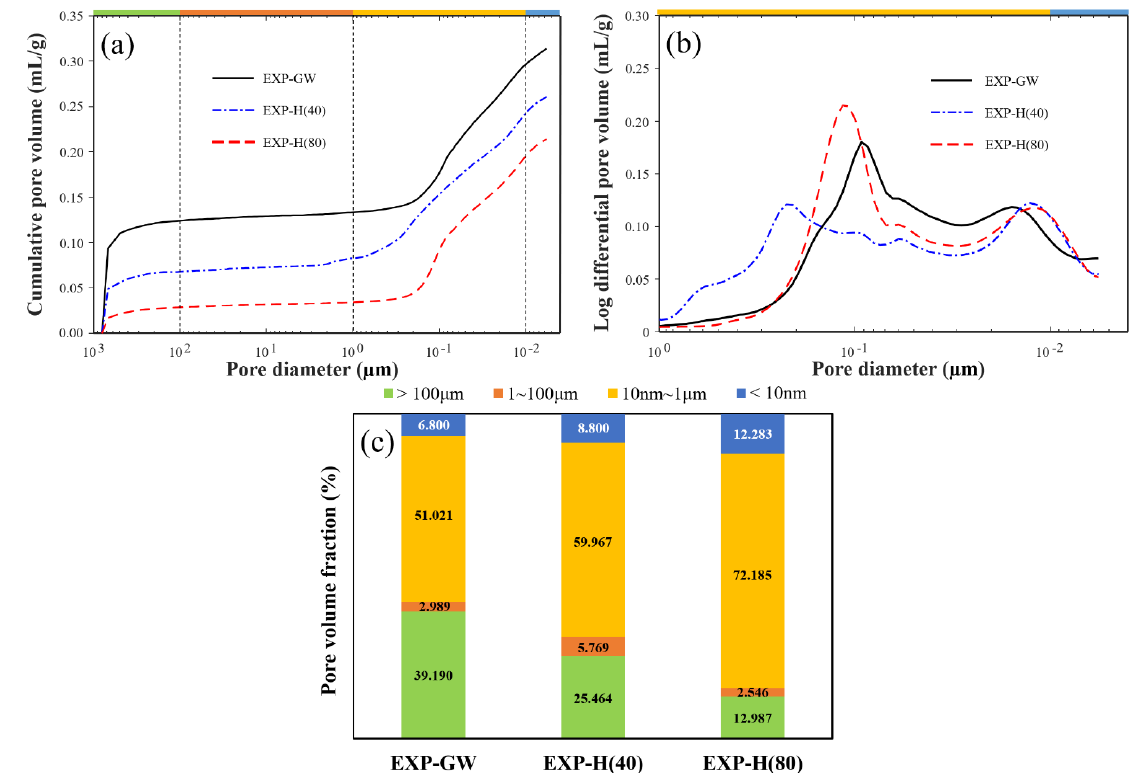
Figure 7. MIP test results: ( a ) Cumulative pore volume according to mercury intrusion; ( b ) log differential pore volume under 1 μ m pore diameter; ( c ) pore volume fraction.